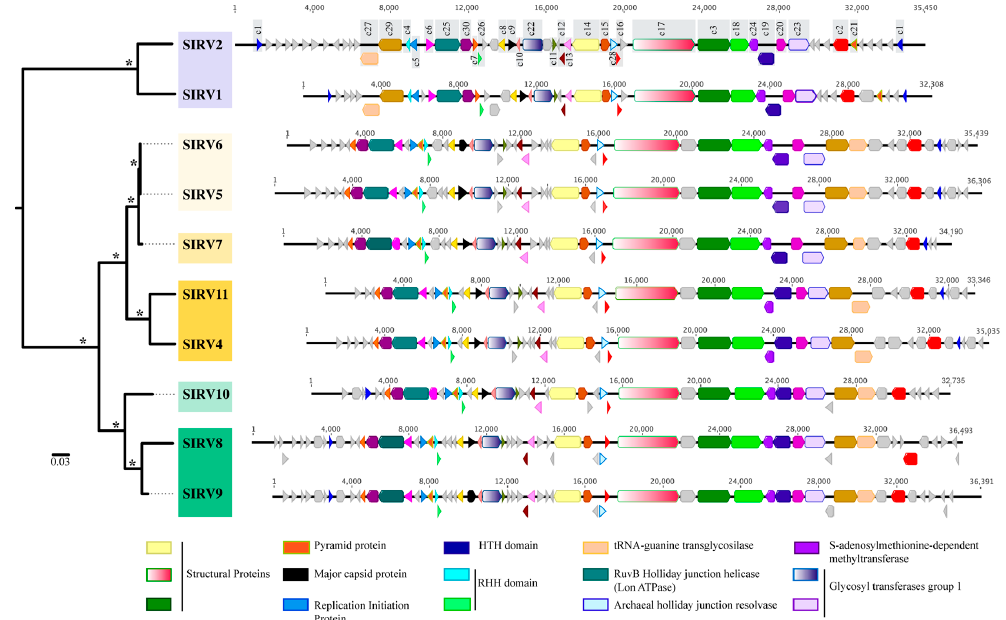
Figure 2. Maximum Likelihood phylogeny of a concatenated nucleotide alignment of SIRV core genes. Asterisks (*) at branches indicate 100% bootstrap support as a percent of 1000 replicates. Scale bar represents substitutions per site. Colored boxes highlight strains by geographic location (yellow: Nymph lake, green: Norris Geyser Basin and blue: Iceland). Genome maps of the SIRVs are shown to the right. Genes shown in color represent core genes and cluster numbers are denoted on the type virus SIRV2. Annotations or predicted function (if available) for core genes are shown. Variable genes are shown in gray.